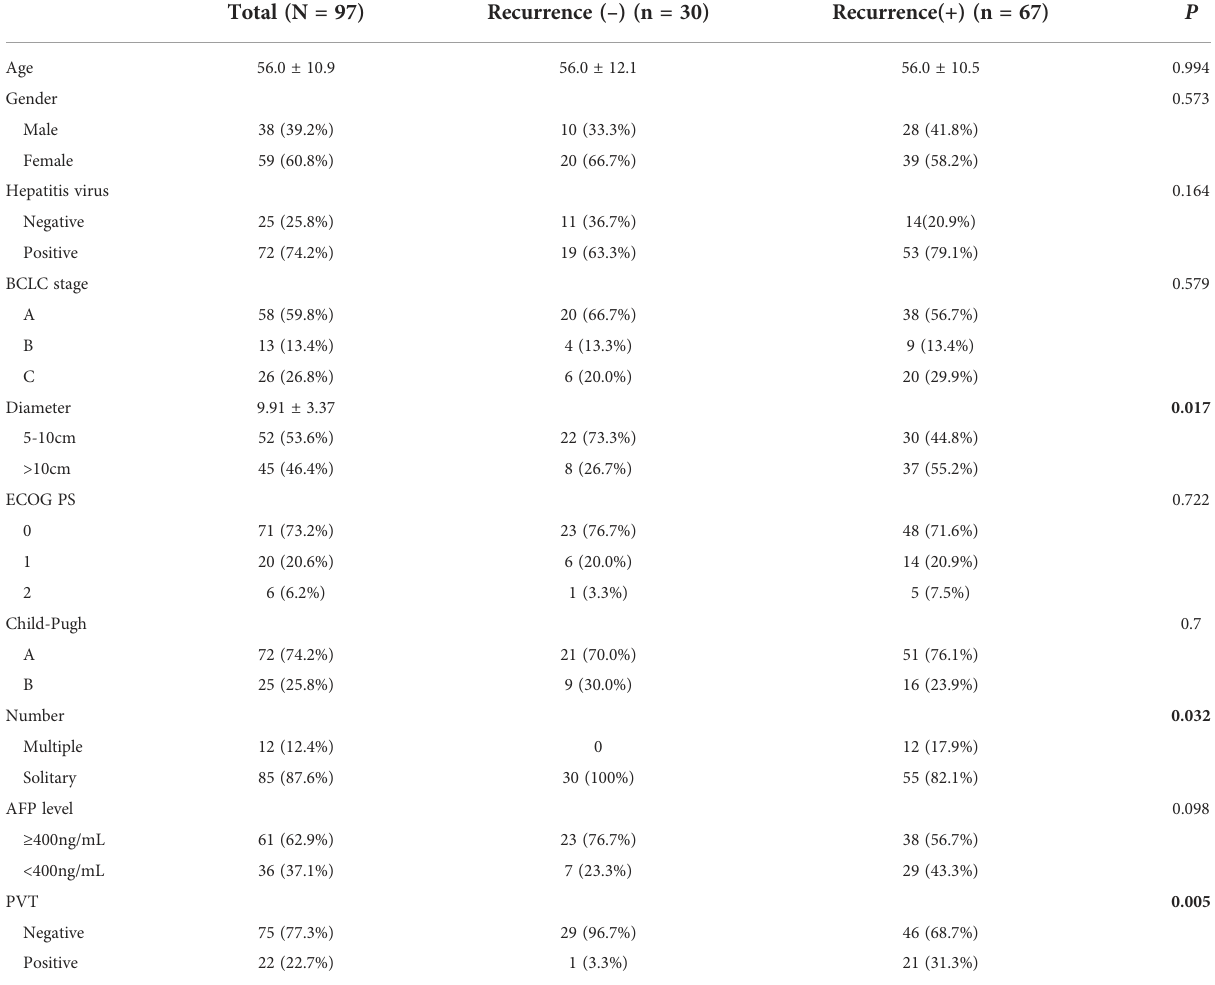
TABLE 1 The Baseline Clinical Characteristics of the Patients with Large